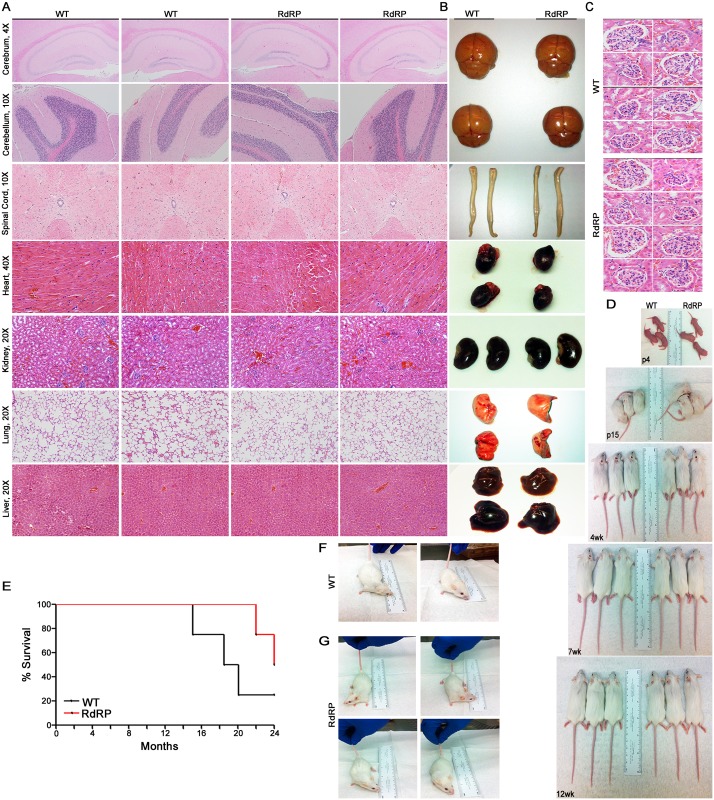
RdRP mice appear indistinguishable from WT controls.(A) Histological examination of WT and RdRP transgenic mice. Tissues were harvested from uninfected age-matched, sex-matched adult FVB mice (n = 2 per genotype). Histological examination was performed on formalin-fixed paraffin-embedded tissue after hematoxylin and eosin staining. (B) Gross tissue morphology. Tissues were harvested from uninfected age-matched, sex-matched adult FVB mice (n = 2 mice per genotype). (C) Kidney tissues were closely examined (40X) for signs of glomerulonephritis. (D) Sex-matched WT (n = 3) and RdRP (n = 3) mice were randomly chosen and photographed at different time points throughout their development. Mice are age-matched at postnatal (p) day 4, p15, 4 weeks (wk), 7 wk, and 12 wk. (E) Survival curve of female WT (n = 4) and RdRP (n = 4) mice in the absence of infection. (F and G) WT (F, n = 2) and RdRP mice (G, n = 4) from (E) were photographed at 20 months of age.